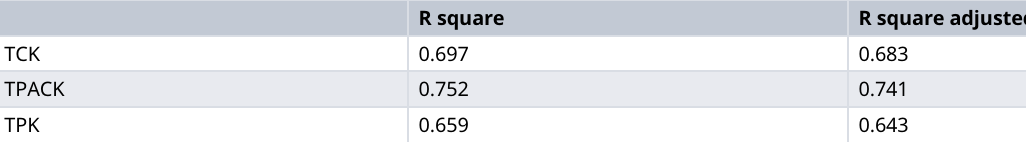
Table 5. R 2 and R 2 adjusted for calculating effect size.